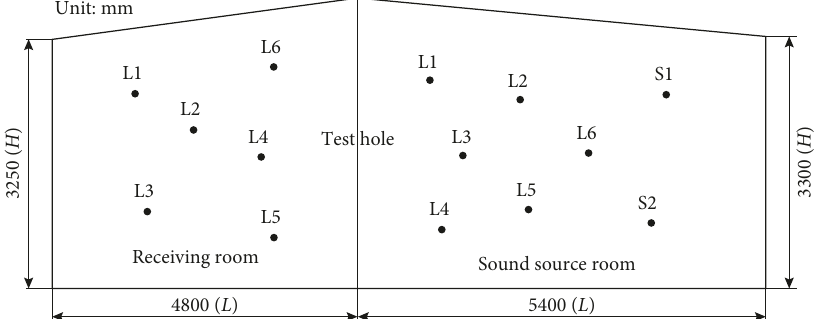
Figure 4: Diagram of laboratory, the layout of sound sources, and measurement